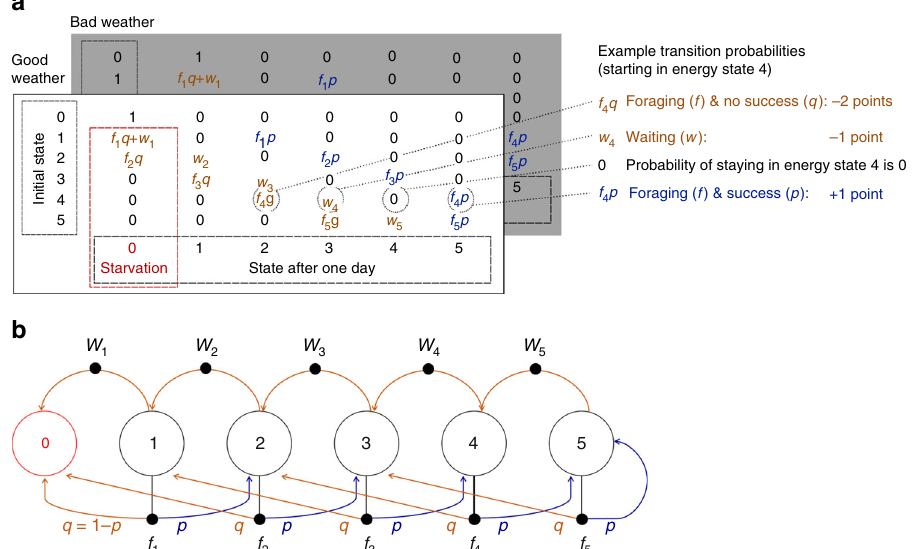
Fig. 2 Markov decision process underlying the sequential decision-making task. a Example transition matrices used for determining the value differences between the two choice options according to the optimal policy (corresponding to the forest in Fig. 1). The entries in the matrices are the probabilities to transition from the initial energy state (rows) to the fi nal energy state (columns) in one step. These entries (and their positions within the matrix) depend on the weather types of the forests and on the choice patterns. Many of the entries are 0, which means that transitions between the respective initial and fi nal states are impossible. The forest is speci fi ed by the probability of foraging success p (with q = 1 − p ) and the magnitude of gains and losses. These magnitudes are re fl ected in the positions of the probabilities within the matrix. Choices are re fl ected by the probabilities for foraging f and waiting w (with f = 1 − w ). The probabilities f and w depend on the initial state and are indexed accordingly. Additionally, the optimal policy depends on the number of remaining days in the forest since there is a fi nite horizon with a maximum number of fi ve days. Starvation is absorbing, which is why the probability of staying in state zero is 1. There are two corresponding transition matrices for the two weather types. Backward computation is used to determine the value differences between the two choice options according to the optimal policies. That is, the values of the two choice options are fi rst evaluated according to the last day in the forest, then according to the second-last day, etc. b The state transition diagram (for one weather type) corresponding to the example transition matrix in a . Large circles depict (energy) states and small fi lled circles depict the two actions to choose from. Arrows indicate transitions between states. For clarity, only one weather type is shown. In total, each forest type comprises 12 states = 6 (energy states)× 2 (weather